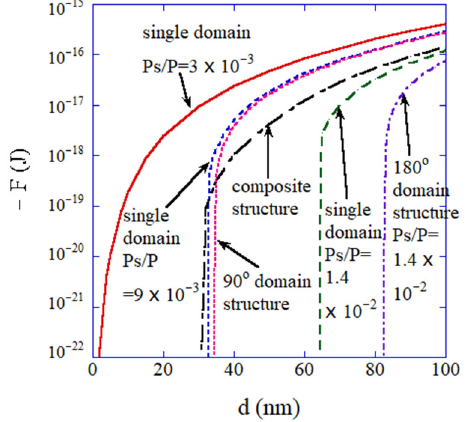
Figure 7. Theoretically calculated free energy as a function of the particle size. Reprinted with per- mission from Ref. [131]. Copyright 2013, the American Chemical Society.